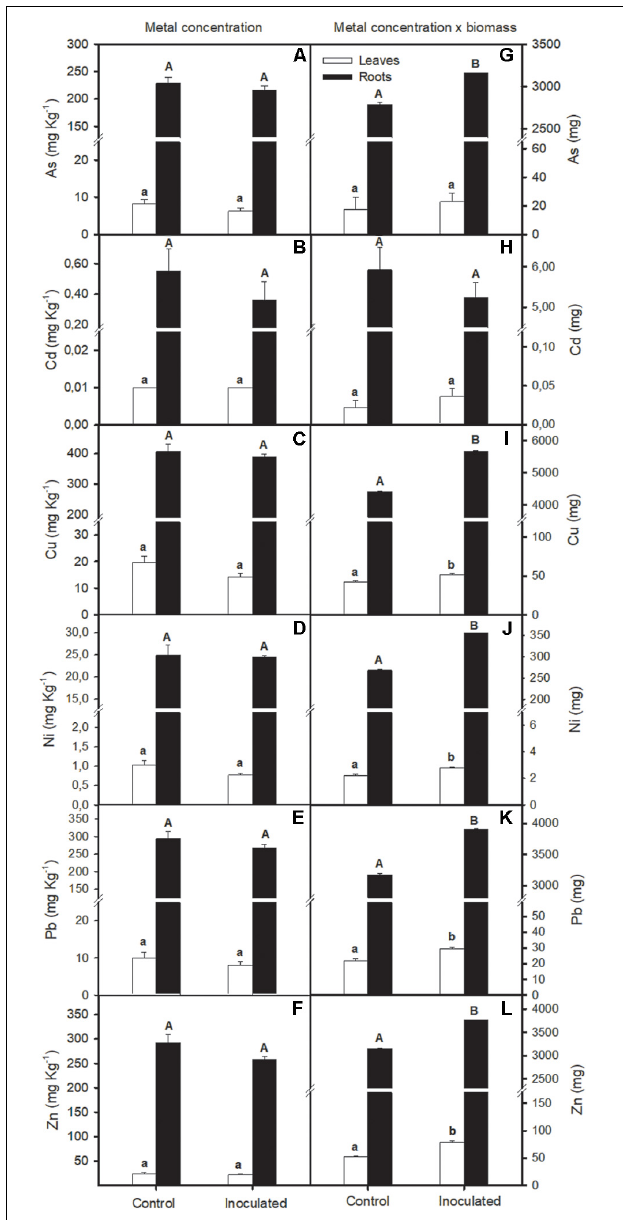
FIGURE 5 | Effect of soil bioaugmentation in polluted Odiel sediments on S. ramosissima heavy metal accumulation after 30 days of treatment initiation. In the left column, total (A) arsenic, As, (B) cadmium, Cd, (C) copper, Cu, (D) nickel, Ni, (E) lead, Pb, and (F) zinc, Zn, for leaves and roots of S. ramosissima . In the right column, total concentration values have been normalized for S. ramosissima biomass after 30 days of treatment (G–L) . Values are means ± S.E. ( n = 3). Different capital letters indicate statistical differences between inoculation treatments in roots and different lower case letters in leaves ( p <